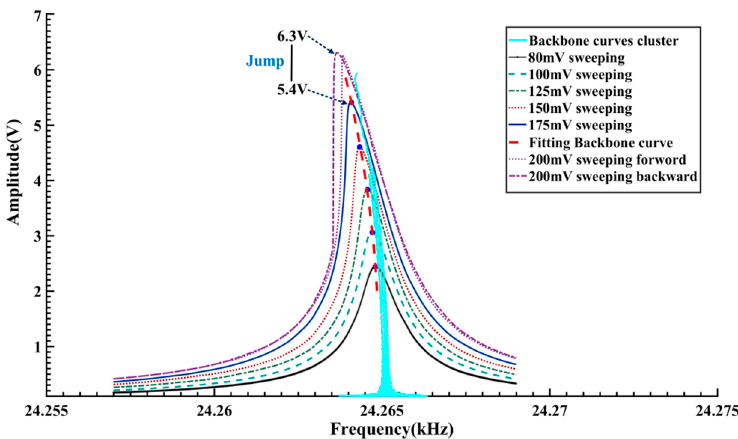
Figure 14 . Comparison between the Backbone curves cluster and frequency sweeping measurement results.